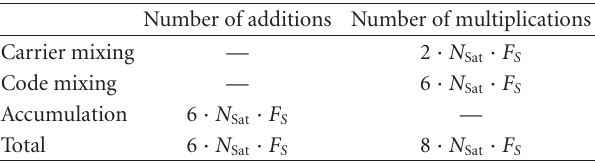
Table 1: Amount of integer operations per second necessary to process N Sat satellites.